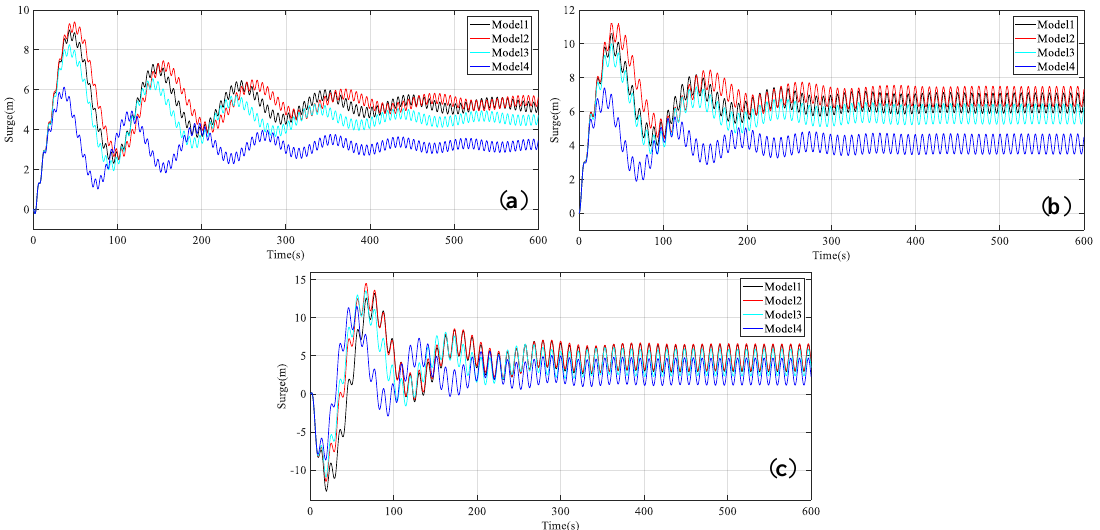
Figure 8. Time domain curves of the surge motion of Models 1~4: ( a ) LC1; ( b ) LC2; and ( c ) LC3.